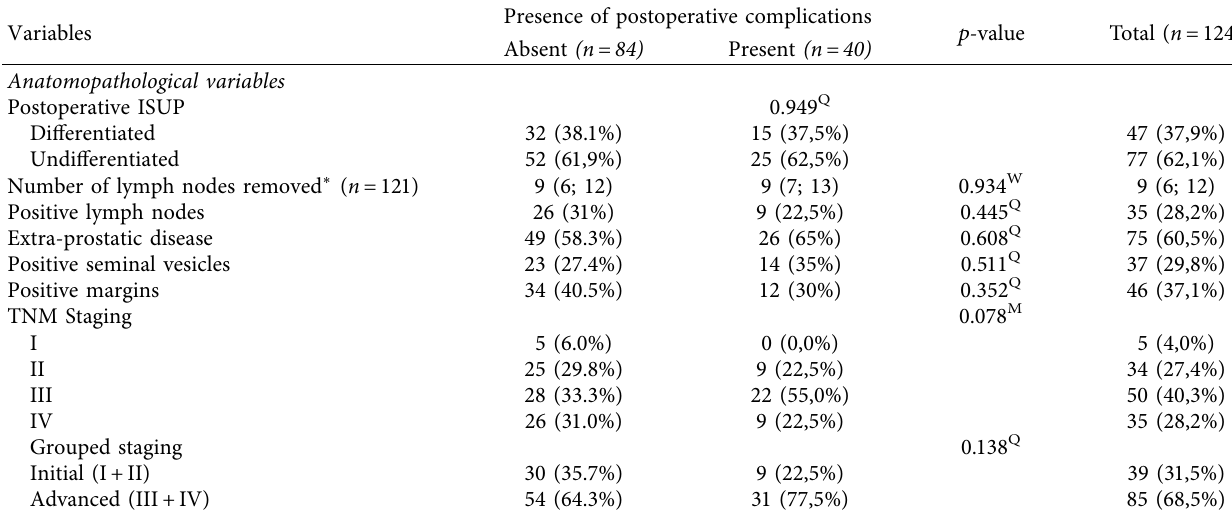
Table 2: Univariate analysis of anatomopathological characteristics and the occurrence of postoperative complications.